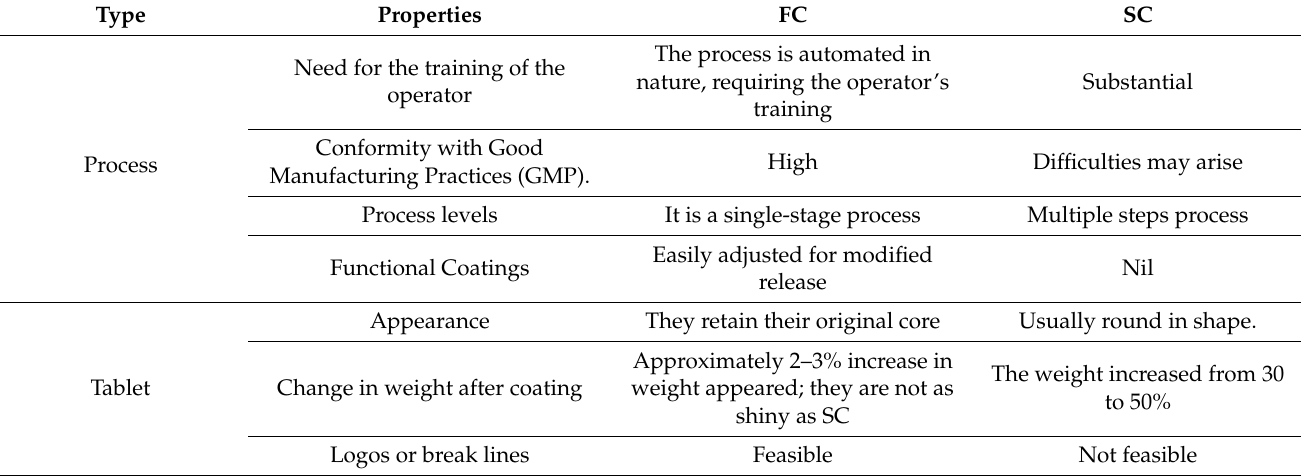
Table 3. Characteristics between SC and FC